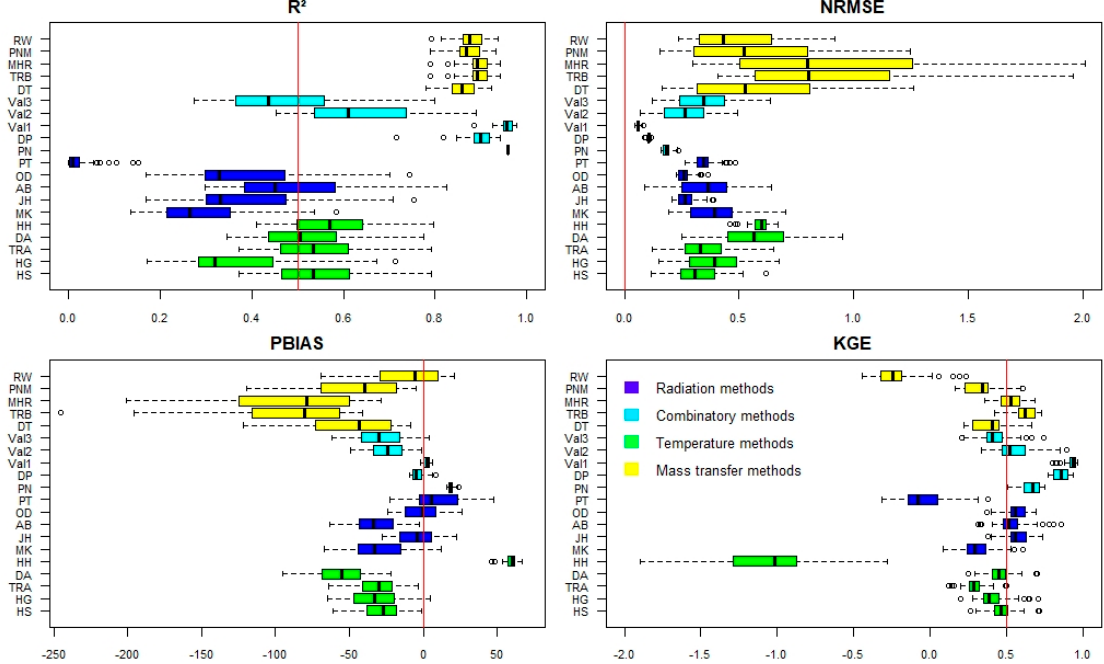
Figure 2. Performance of the methods according to the selected evaluation criteria. The red line in each figure represents the threshold values of each evaluation criterion.